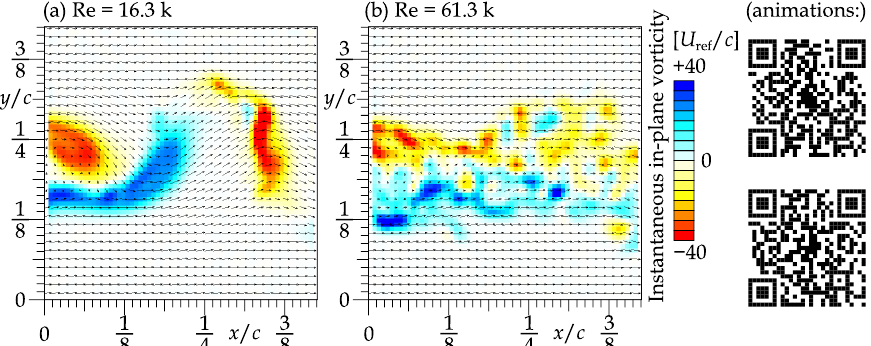
Figure 3. The example of instantaneous velocity fields at chord-based Reynolds numbers 1.63 × 10 4 ( a ) and 6.13 × 10 4 ( b ), both at zero angle of attack. Only every second velocity vector is displayed. The color in the background represents the z -component of vorticity ω = ∇ × (cid:126) u . The QR codes link to http: //home.zcu.cz/~dudad/PIV_uplav_3ms.gif and http://home.zcu.cz/~dudad/PIV_uplav_12ms.gif (accessed 20 July 2021) show the pair of photos used to draw this